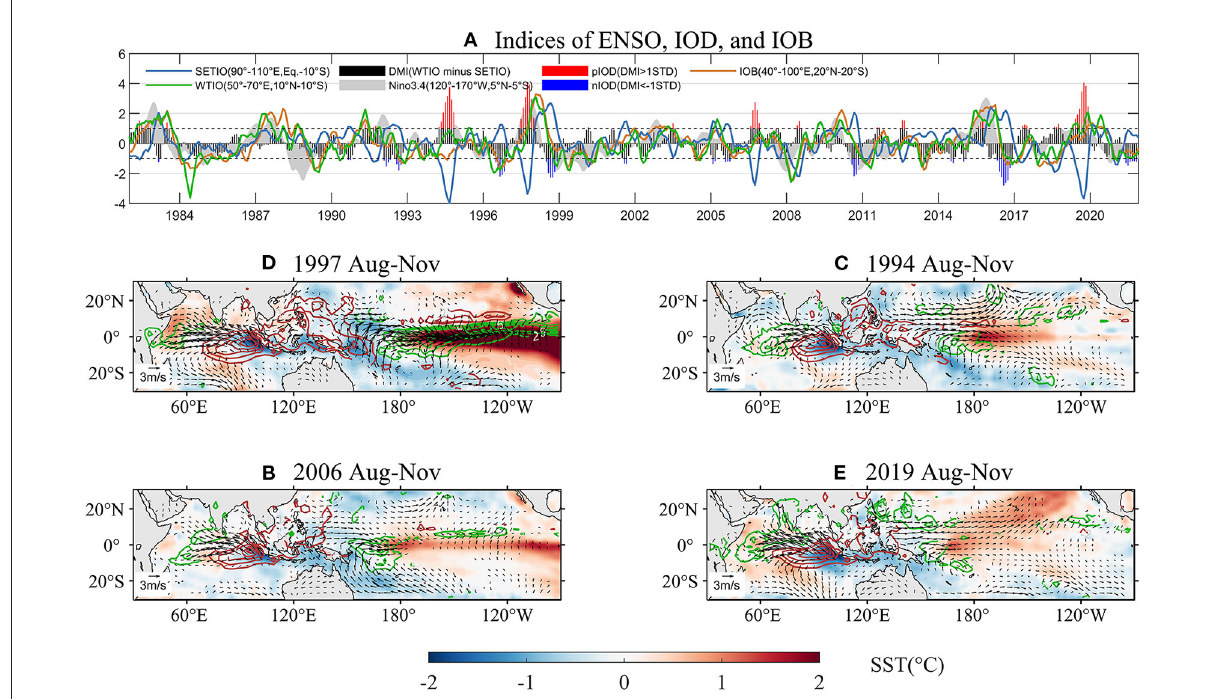
FIGURE7 (A) Time series of standardized SST indices of Nino3.4, DMI, IOB, SETIO and SWTIO from 1982-2021. (B–E) SST (shading, ◦ C), precipitation (contour, mm/day), and wind anomalies (vectors, m/s) of IOD peak season (Aug-Nov) for strong positive events in 1997, 1994, 2006, and 2019, respectively. The DMI is defined by the difference of area-mean SST anomalies between the western tropical Indian Ocean (WTIO, 50 ◦ -70 ◦ E,10 ◦ N − 10 ◦ S) and the southeastern tropical Indian Ocean (SETIO, 90 ◦ -110 ◦ E, Eq.-10 ◦ S). Data are based on OISST from 1982-2021, CCMP wind from 1988-2021, CMAP precipitation from 1979-2021. Linear trends and seasonal cycle are removed based on each period